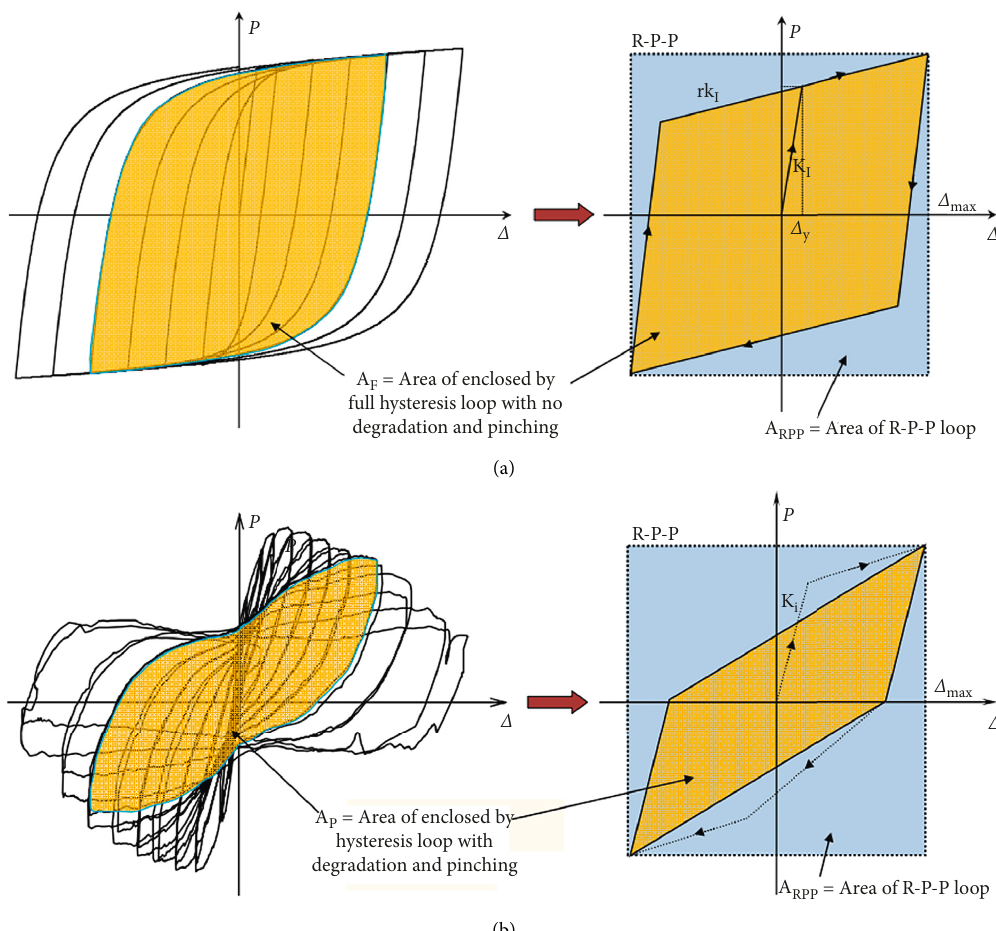
Figure 4: Effects of earthquake reciprocating behavior on sections [27]. (a) The hysteresis cycle and its equivalent model. (b) Reduced hysteresis and its equivalent